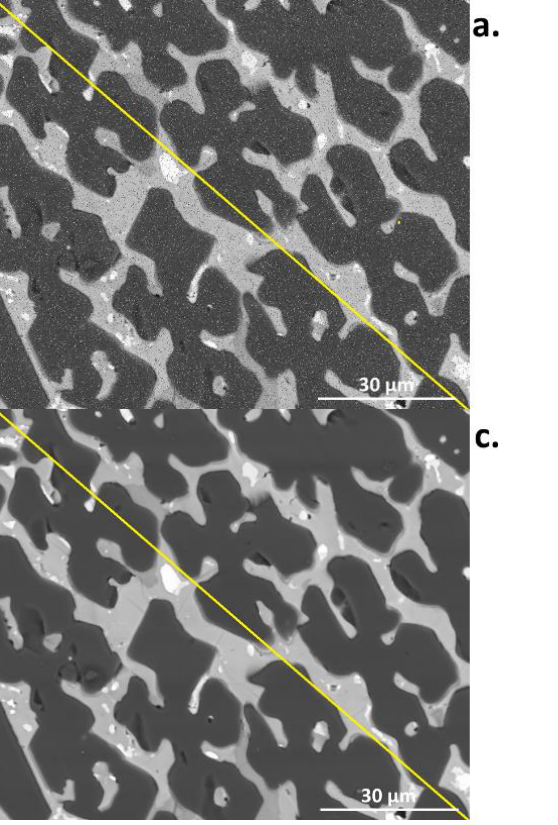
Figure 6. Comparison of the image and noise with its profile ( a , b ) vs. the image after noise reduction and its profile ( c , d ); the yellow line shows the test site for creating the profile.